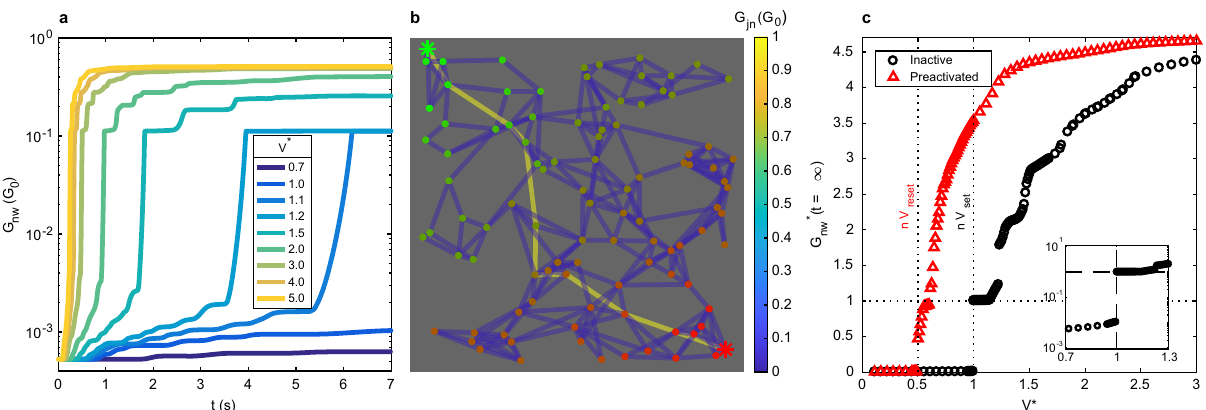
Fig. 2 Threshold network activation under constant bias. Simulations using a 100 nanowire, 261 junction NWN. a DC activation curves for an initially inactive NWN ( Λ = 0 for all junctions) for increasing applied voltages ( V * = V / V th ), with V th = 0.09 V. b Snapshot visualisation of NWN, showing formation of fi rst transport pathway, corresponding to shortest path length n . c Steady-state network conductance (with G (cid:3) V * . Black circles are for an initially inactive network. Red triangles are for a network pre-activated by a 1.8 V DC bias. Inset shows a zoom-in near V * = 1 with a logarithmic